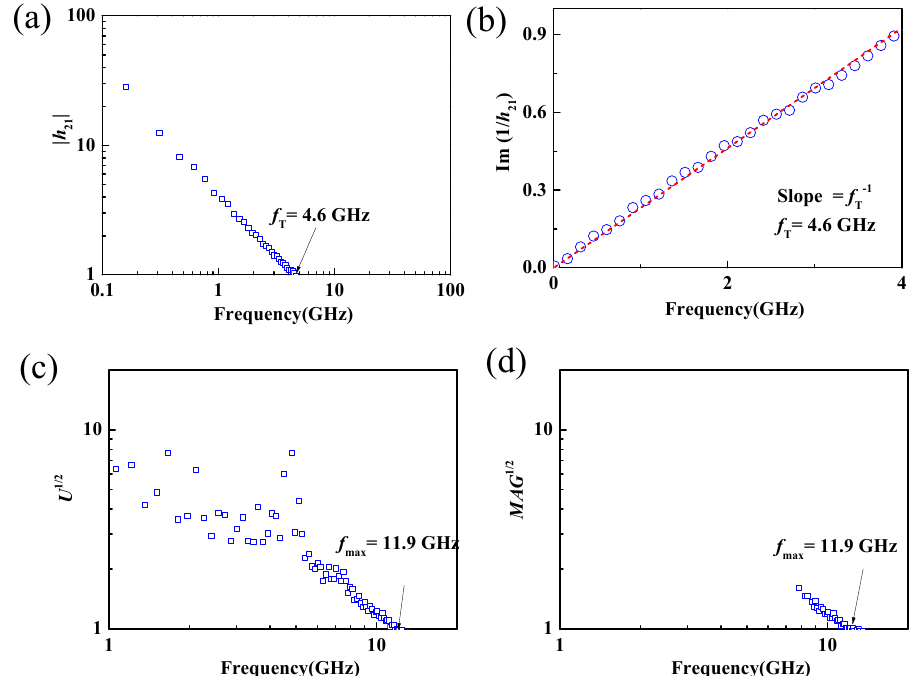
Figure 5. ( a , b ) Small-signal current gain | h 21 | and Im(1/ h 21 ) versus frequency. Extrinsic f T of 4.6 GHz can be extracted. ( c , d ) The corresponding unilateral power gain and maximum available power gain versus frequency. An extrinsic f max of 11.9 GHz can be extracted.